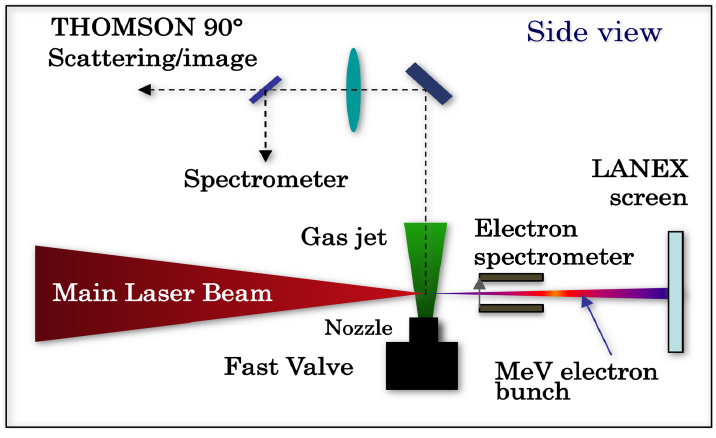
Schematic layout of the experimental setup: side view showing the main interaction geometry of the laser beam relative to the gas-jet, the magnetic electron spectrometer and the LANEX screen for detection of